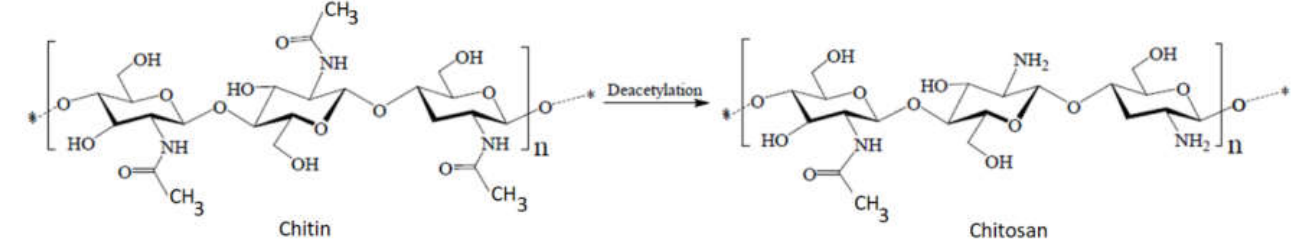
Figure 1. Partial deacetylation of chitin to chitosan according to [7]. The structure of chitosan includes an “acetylated” part and a “deacetylated” part; the molecular structure of the monomeric units that are repeated in the chitosan molecule is shown in Figure 2. If the left side is 2-amino-2-deoxy-β-(1-4)-D-glucopyranose representing the degree of acetylation (DA) of chitosan, the right side is the deacetylated result of the left side, representing the degree of deacetylation of chitosan (DD).